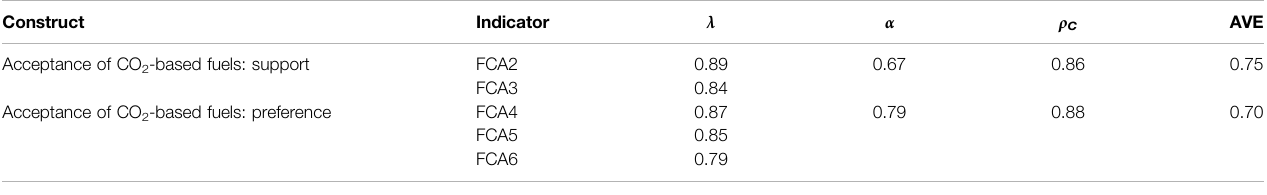
TABLE 3 | Evaluation of the re fl ective lower-order constructs (LOC): original estimate loading ( λ ), internal consistency reliability ( α , ρ C ), and convergent validity (AVE).